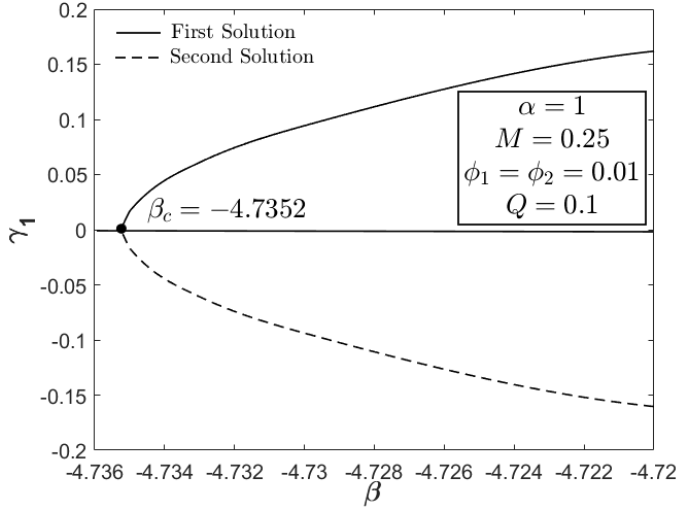
Figure 13. Analysis of solution stability.